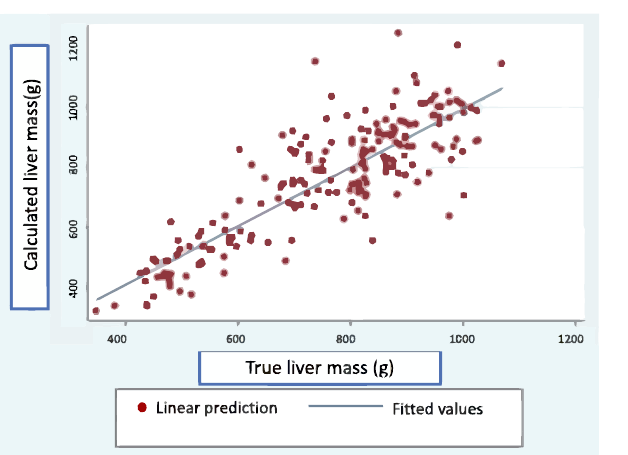
Figure 4. True and calculated liver mass scatter